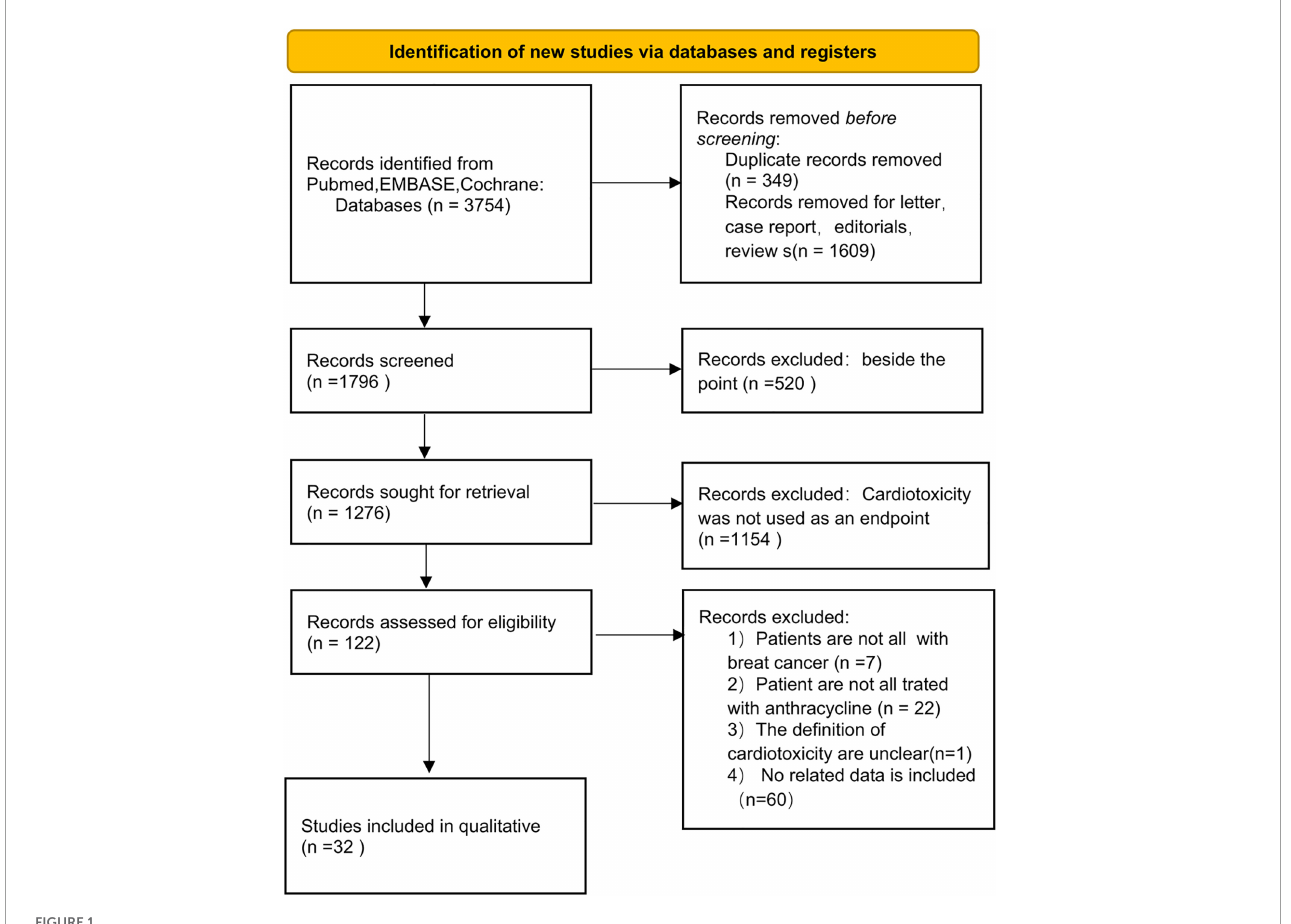
FIGURE1 PRISMA flow diagram for systematic